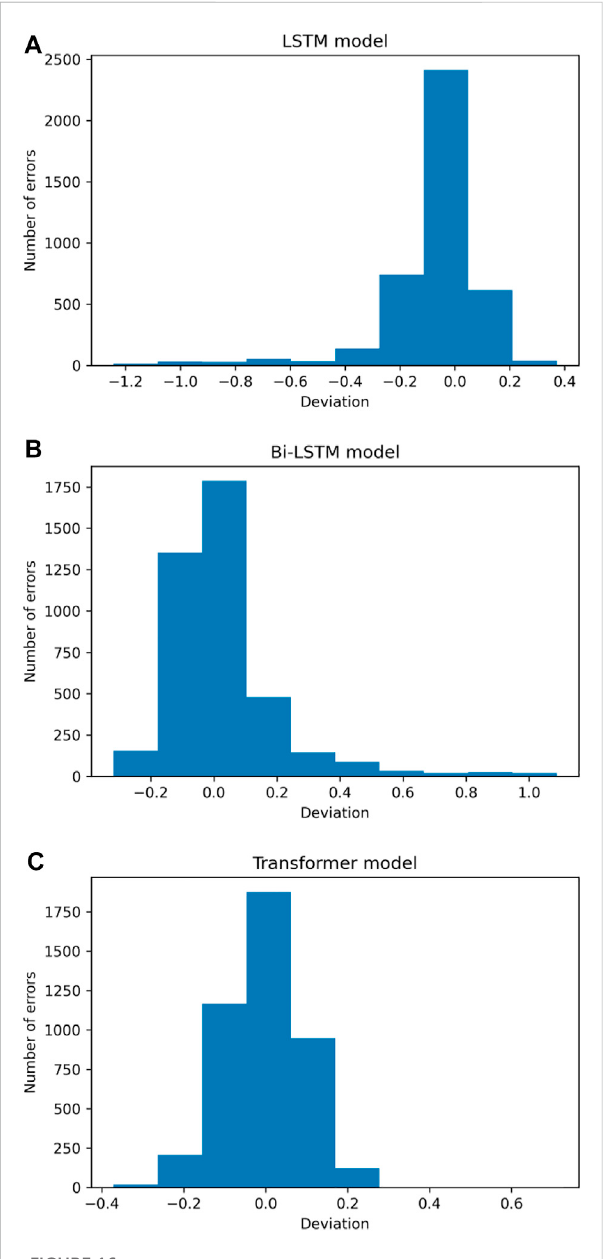
FIGURE 16 Error distribution of the (A) LSTM, (B) Bi-LSTM, and (C) transformer models applied to the Japan earthquake catalogue.